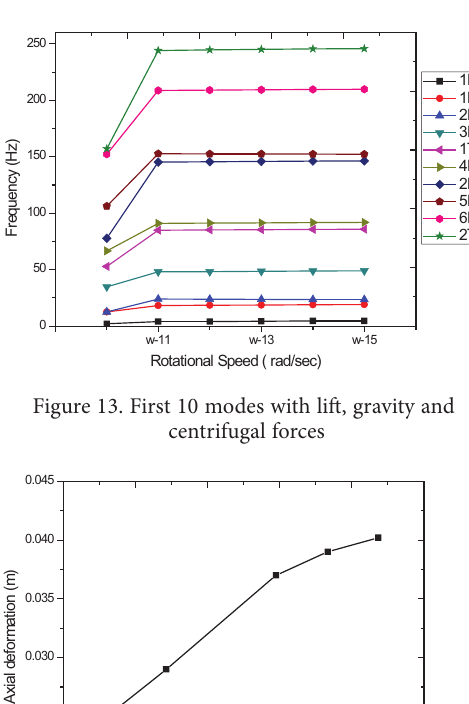
Figure 12. Out of plane deflections with and without centrifugal force